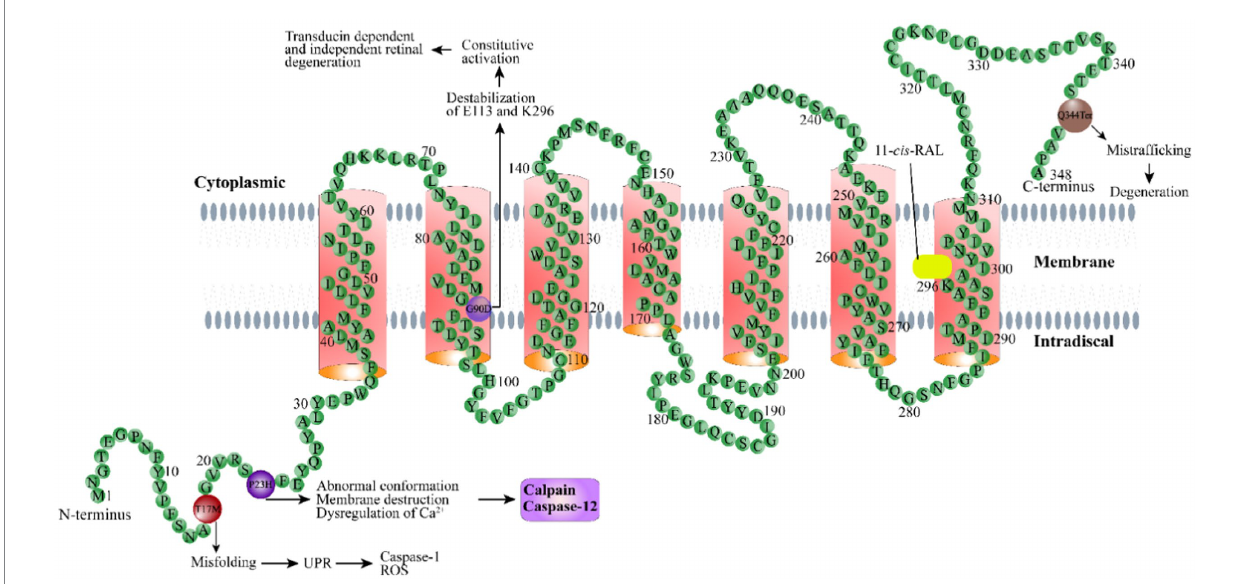
FIGURE 1 Schematic illustration of the rhodopsin structure. Rhodopsin is a G protein-coupled receptor with seven typical transmembrane domains. Representative rhodopsin mutations, including T17M, P23H, G90D, and Q344Ter, as well as the disease mechanisms related to these mutations, are shown. 11- cis -RAL: 11- cis -retinaldehyde.